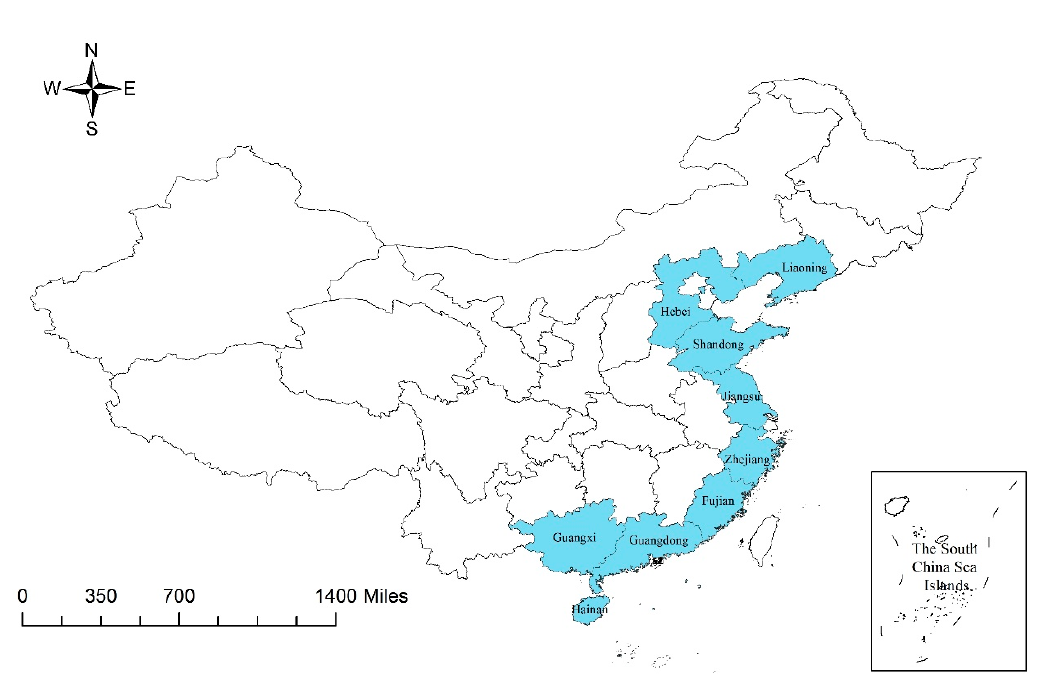
Figure 1. Location of China’s nine coastal provinces.